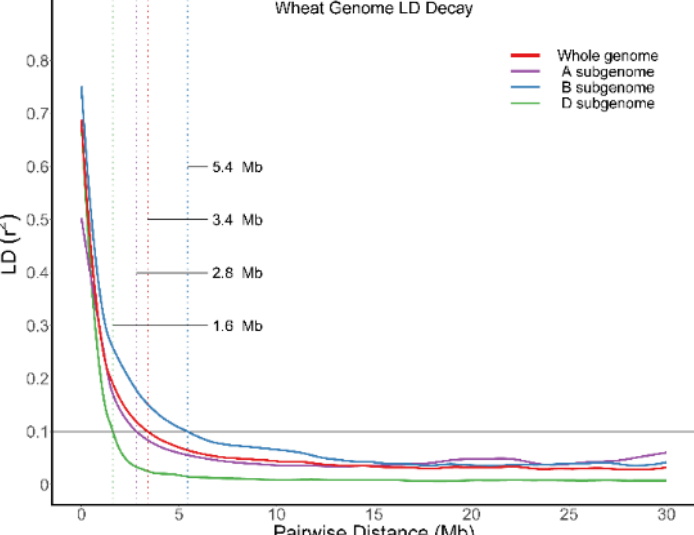
Figure 3. Genome linkage disequilibrium (LD) attenuation map (LD coefficient (r 2 ) greater than 0.8 indicates that SNP is strongly correlated with functional mutation. If LD coefficient is less than 0.1, it can be considered that there is no correlation).